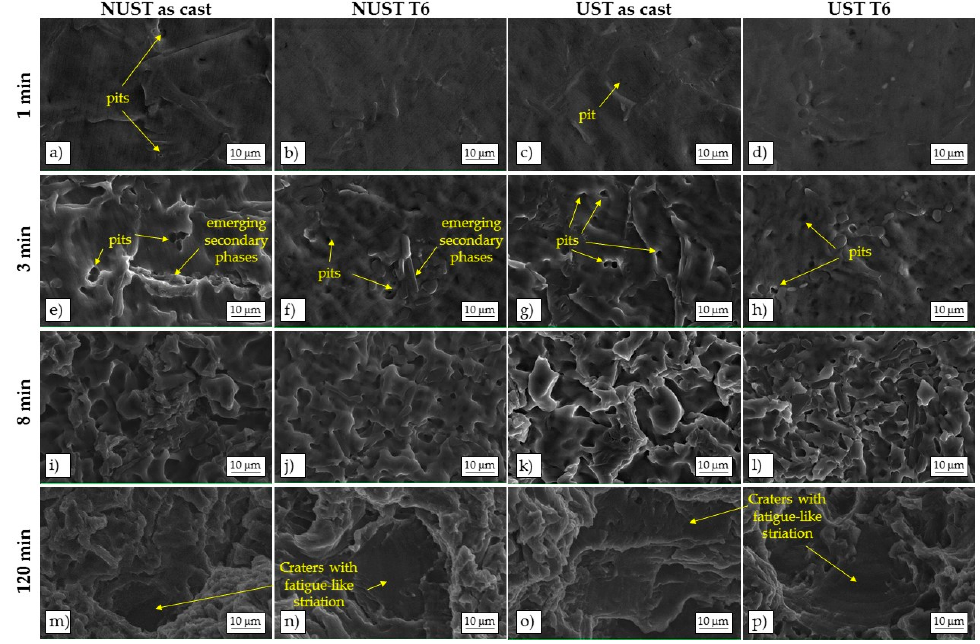
Figure 8. Surface topographies of the damaged areas of NUST as-cast ( a , e , i , m ); NUST after T6 ( b , f , j,n ); UST as-cast ( c , g , k,o ); and UST after T6 ( d , h , l,p ).